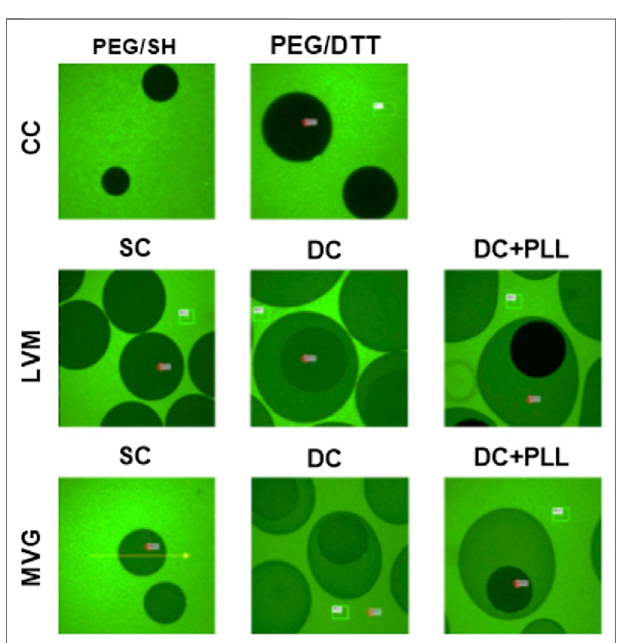
FIGURE 7 | Fluorescence recovery after photobleaching of FITC-IgG. Cell-freeCC and alginate SCsand DCs incubated at 4 ° Covernight with 1 mg/ ml FITC-IgG and imaged for FRAP